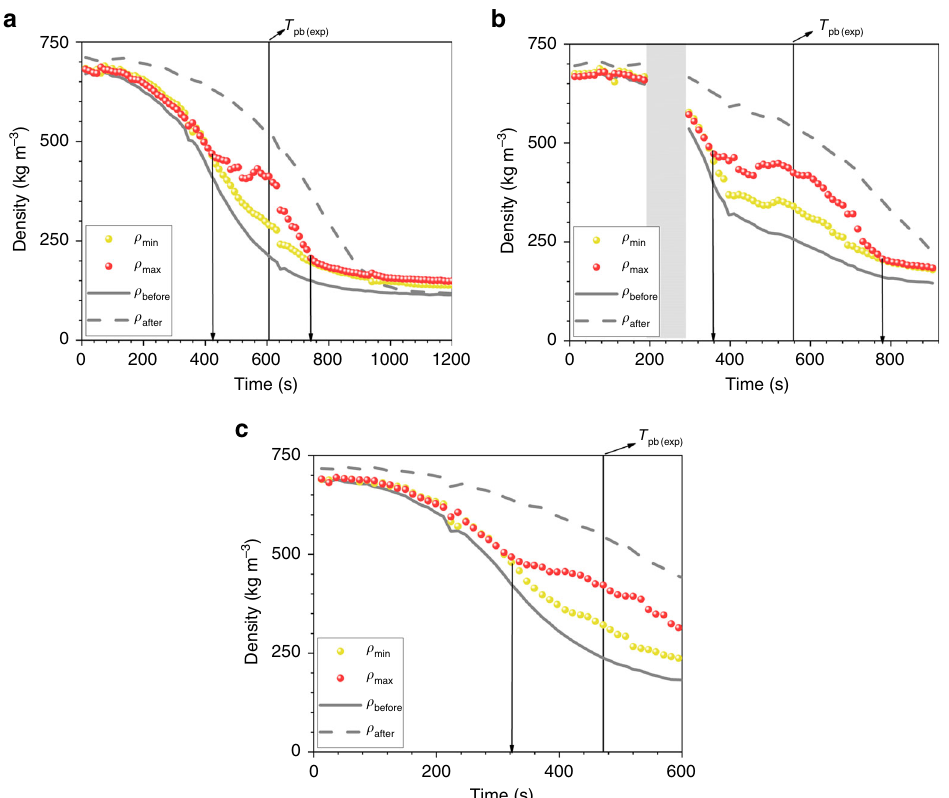
Fig. 8 Time-domain analysis of water density recorded inside the monolith. It presents the variation of min and max densities ( ρ min and ρ max ) at a 225 bar, b 250 bar, and c 270 bar; vertical lines indicate the times at which the curves starts to separate, reach the maximum separation at pseudo -boiling point and when they come back together; the curves showing the density variation before and after the monolith are included for comparison. Source data are provided as a Source Data fi